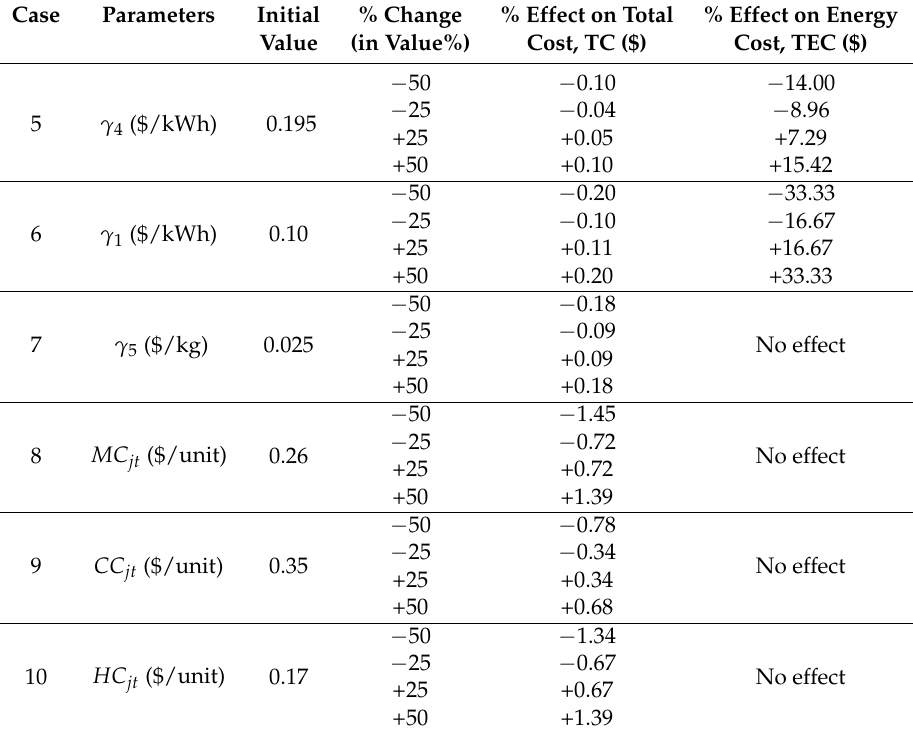
Table 13. Sensitivity analysis of the key parameters of the production